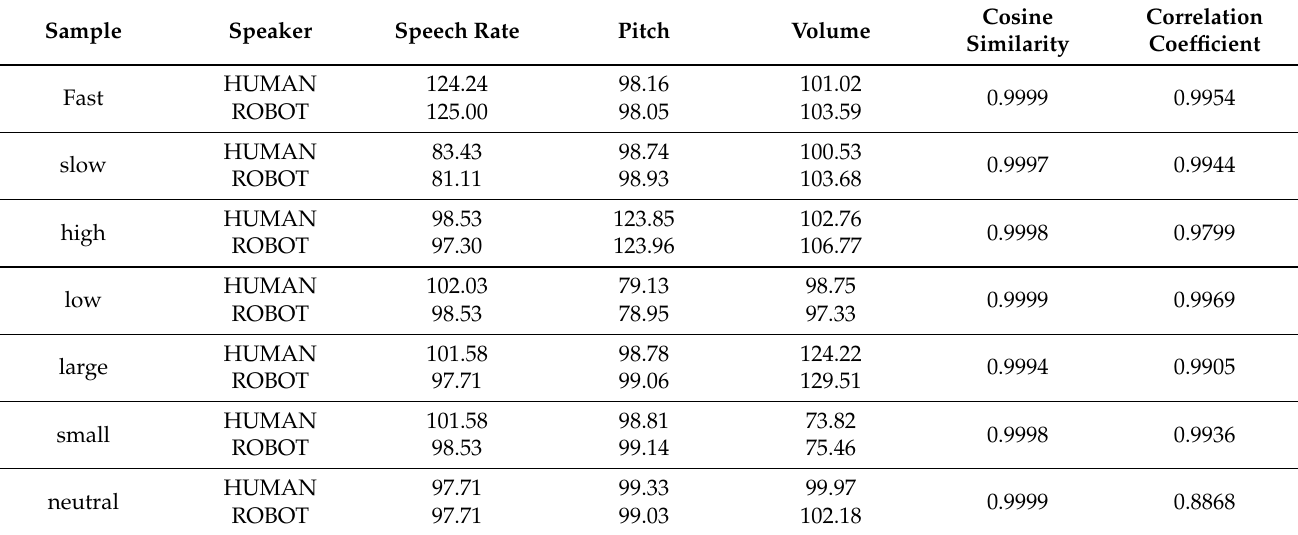
Table A1. Mean values of prosodic features, cosine similarity, and correlation coefficient.